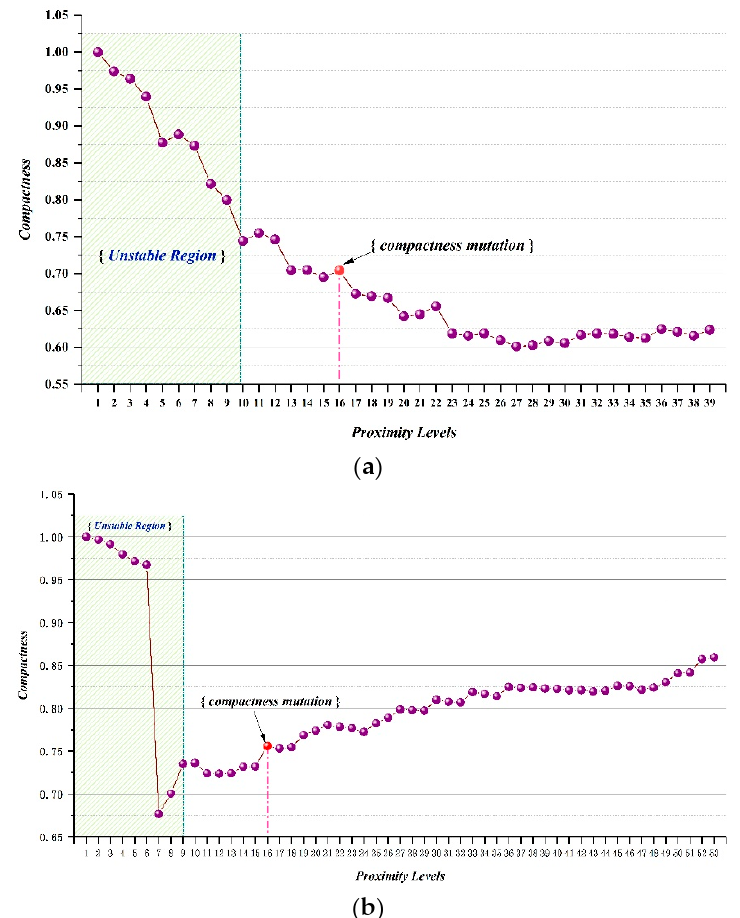
Figure 16. Compactness curve generated by two datasets: ( a ) compactness curve of parcel 1 ; ( b ) compactness curve of Parcel 2 .